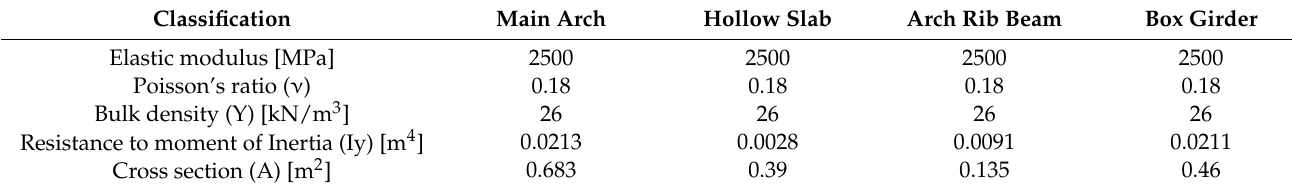
Table 1. Calculation parameters of the